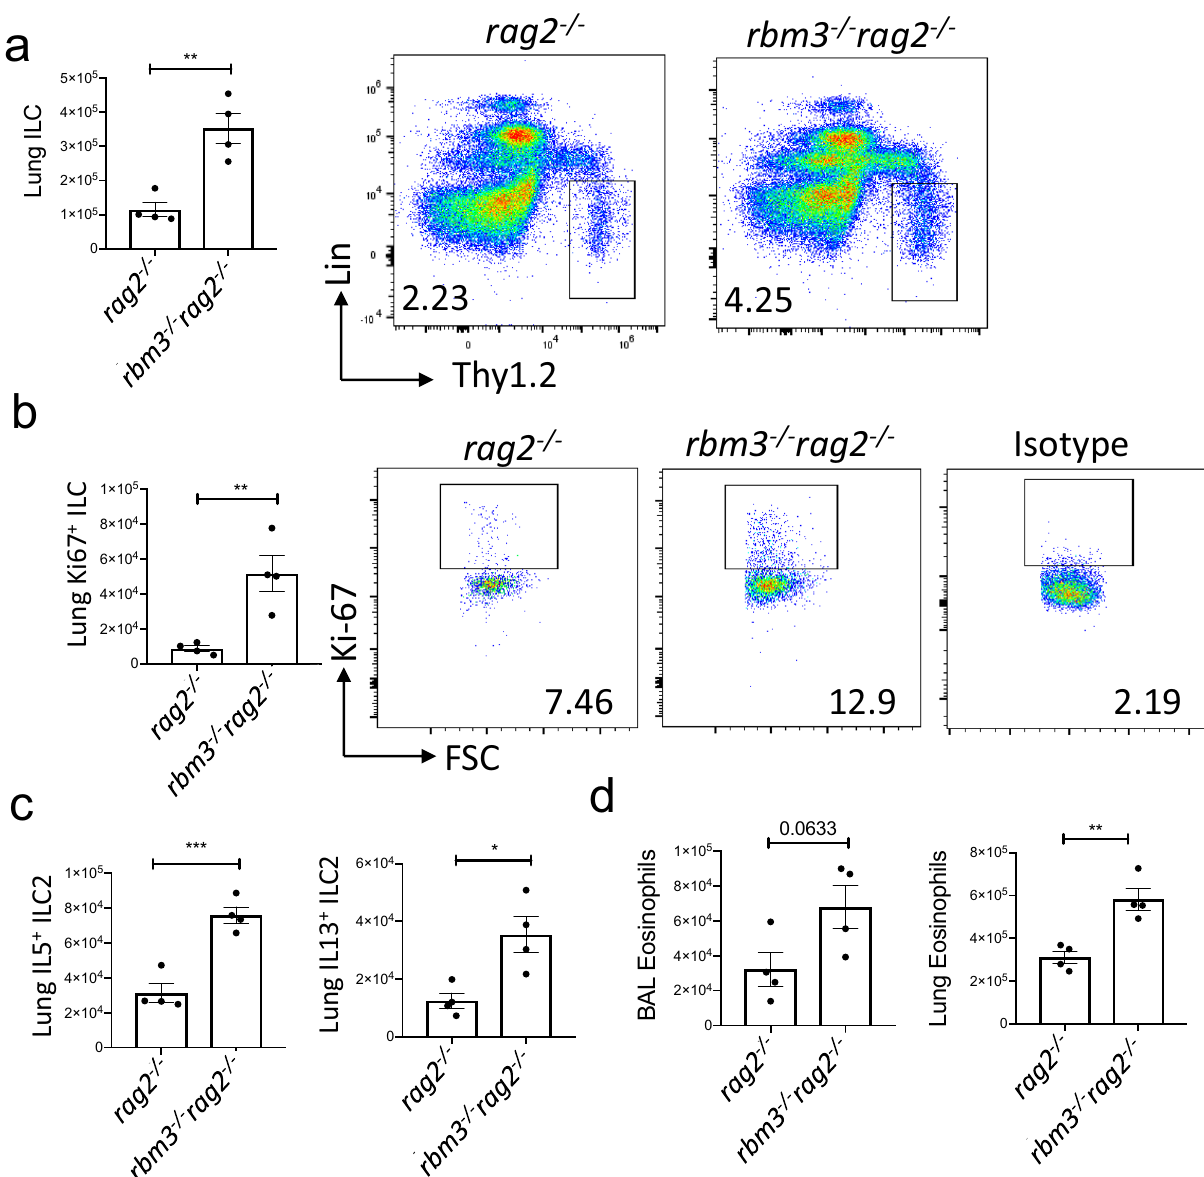
Fig.4|RBM3suppresseslungILC2sindependentofadaptiveimmunity. Rag2 − / −